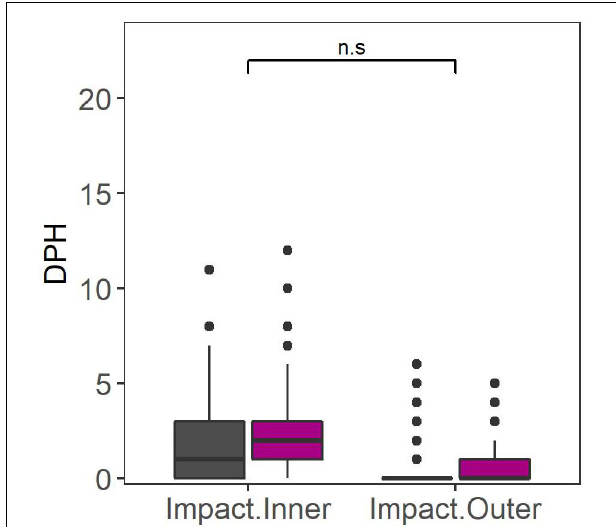
FIGURE 6 | Dolphin DPH for the Impact Inner and Impact Outer CPOD arrays in the Impact Area during the construction of Moray East wind farm (2019): non-piling days (dark gray) and piling-days (magenta). Significance of the interaction between period and array is indicated above the bar at the top: n.s. P >